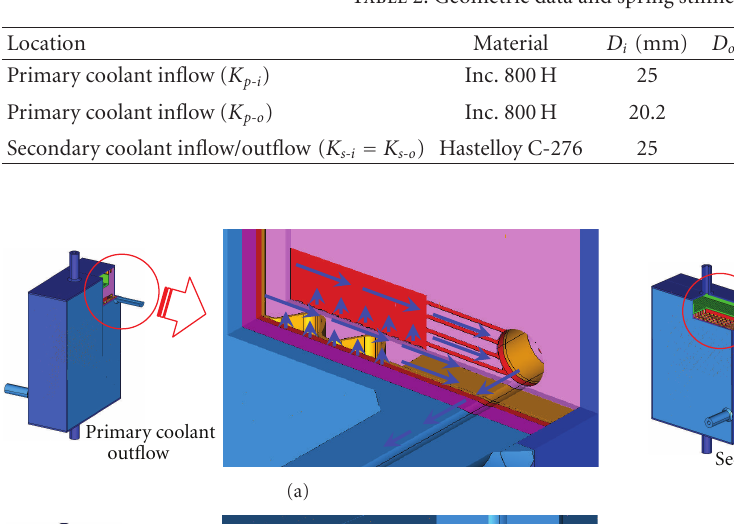
Table 2: Geometric data and spring sti ff ness of the pipelines.